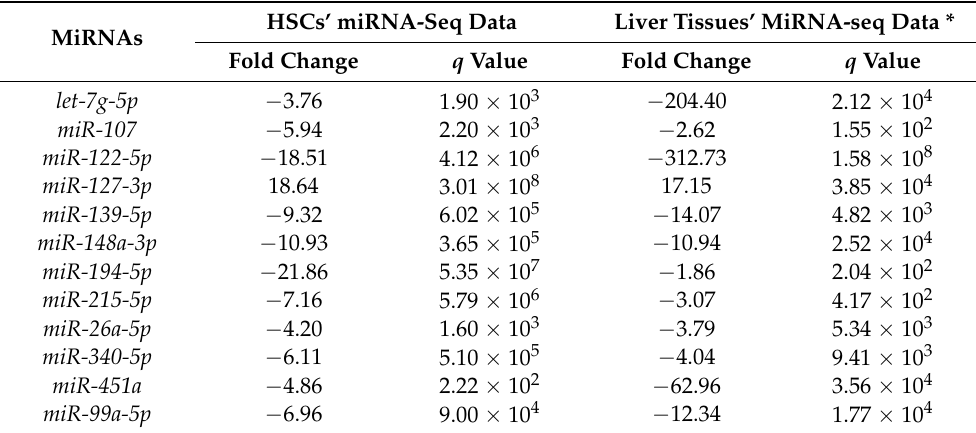
Table 2. Overlapping DEmiRNAs with concordant expression between HSCs’ miRNA-seq data and liver tissues’ miRNA-seq